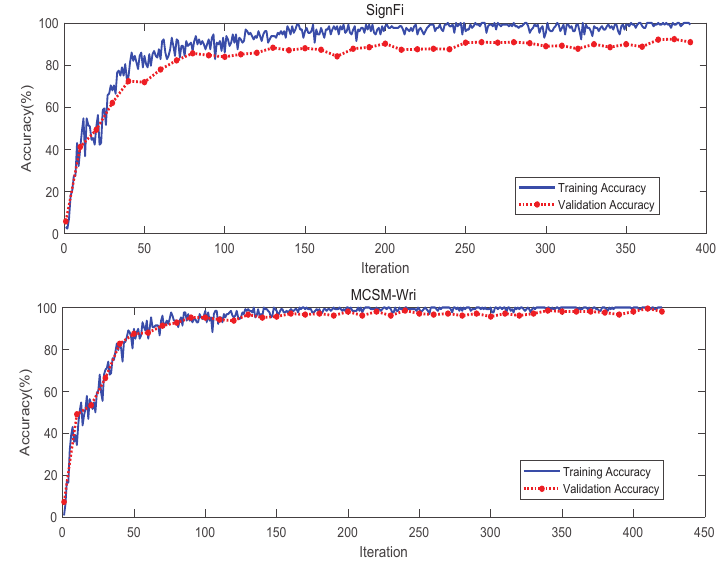
Figure 13. The training and testing process of MCSM-Wri and